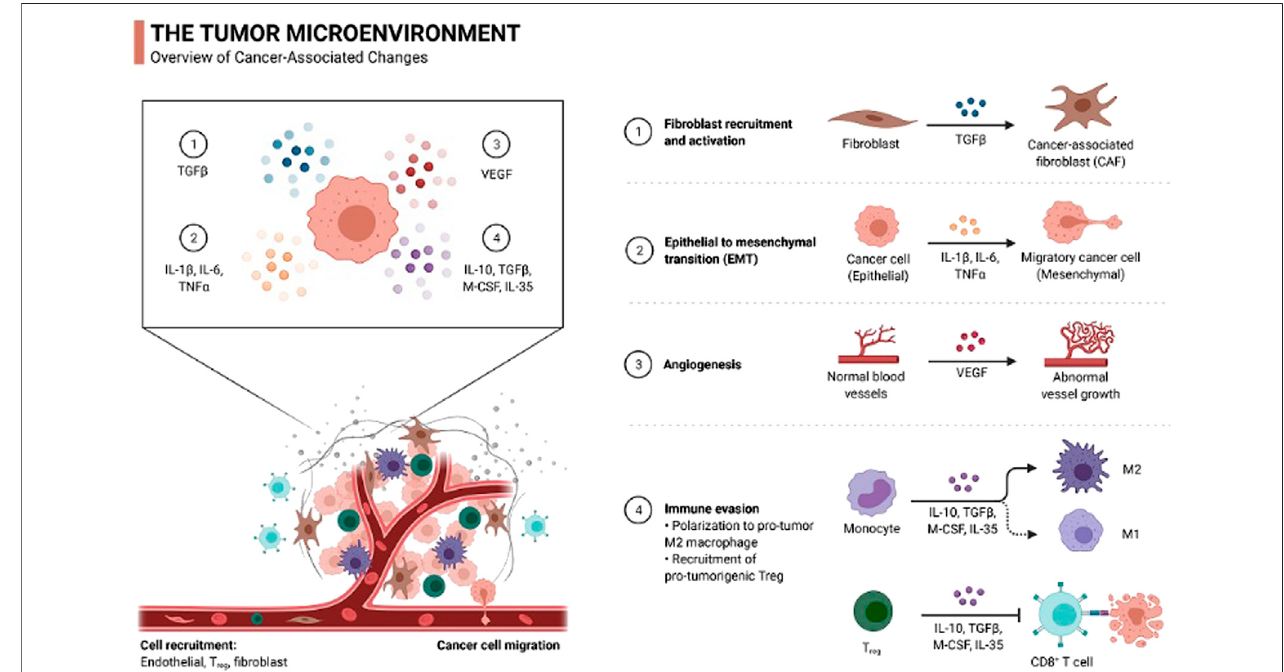
FIGURE1| Differenttypesofcellsand theirfunctionintheEC microenvironment.Themicroenvironment consists ofdifferentcomponents such asmyo fi broblasts, epithelialcells,andimmunecells.(1)TGF- β producedbyin fl uxmonocyteshelpsintheconversionof fi broblaststocancer-associated fi broblasts(CAF).(2)Macrophages induce endometrial carcinogenesis by producing TNF- α , IL-6, and IL-1 β that facilitate the conversion of cancer cells to migratory mesenchyme cancer cells. (3) VEGF produced by tumor cells promotes angiogenesis. (4) High-grade EC carries more M2 macrophages, which facilitates more macrophage recruitment via blood